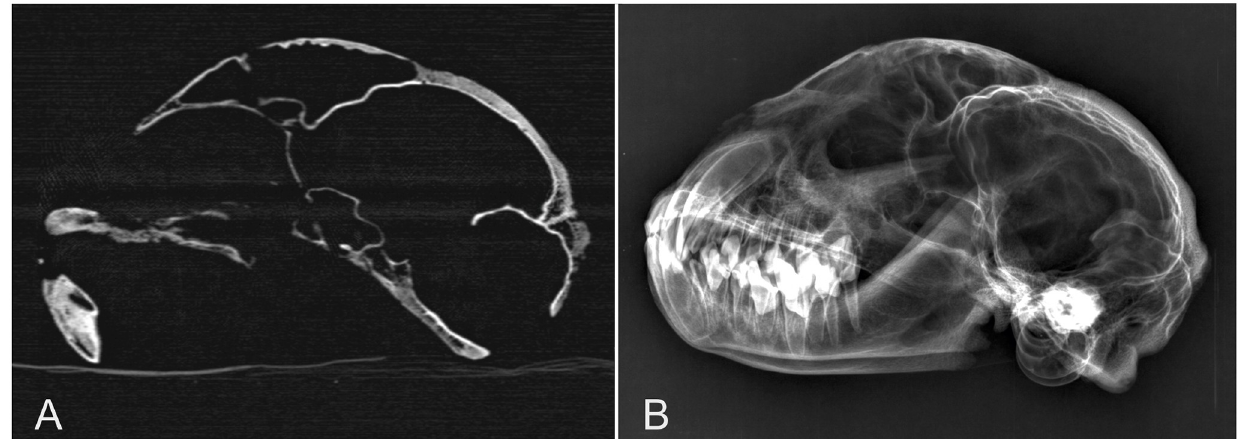
Fig 1. Midsagittal Computed Tomography in a bone window (A) and a corresponding latero-lateral radiograph of a cheetah skull (B).